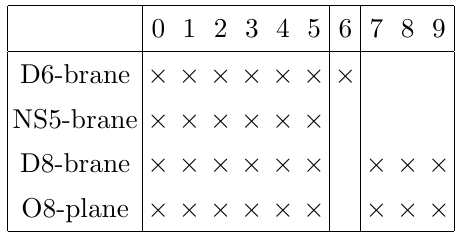
Table 1 . The brane con(cid:12)guration that yields a 6d theory on a tensor branch of a 6d SCFT in Type IIA string theory.